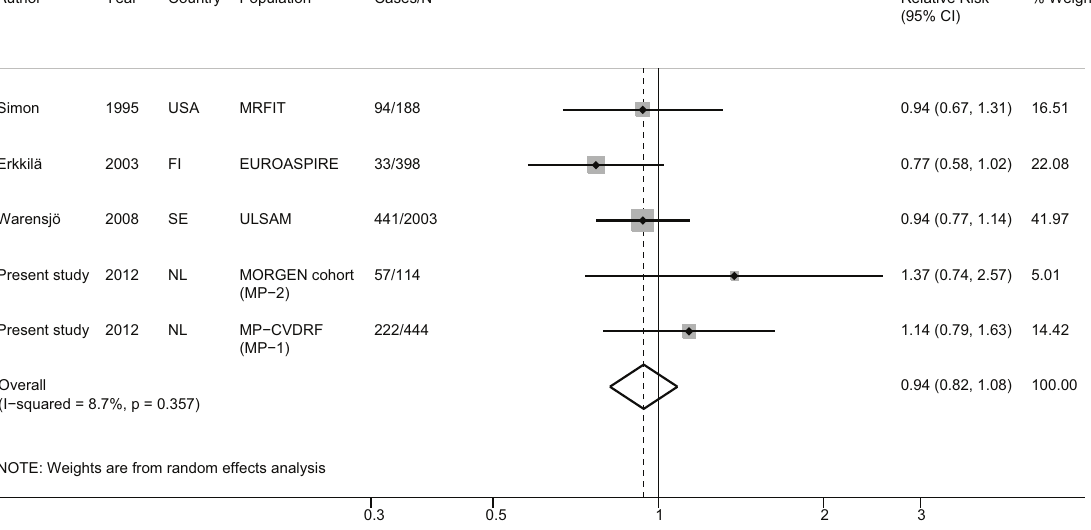
Figure 3. Pooled relative risk of cholesterol ester arachidonic acid and CHD risk.